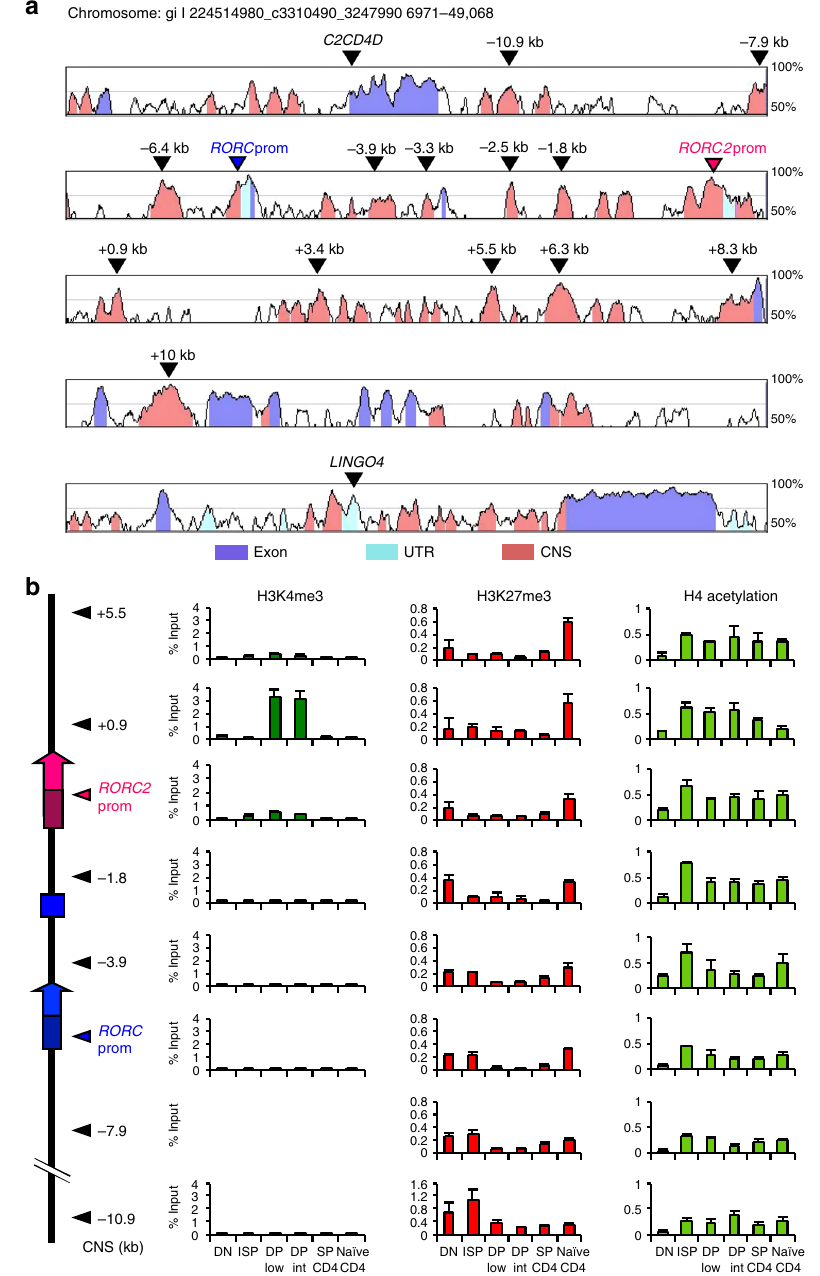
Fig. 2 Global remodeling of the RORC locus during thymocyte differentiation. a Alignment of the human and murine RORC loci, obtained with the VISTA browser. The Y -axis displays the percentage of identity between sequences. Regions with >70% identity are marked in color: Conserved Non-coding Sequences (CNS) in salmon, 5 ′ and 3 ′ untranslated regions (UTR) in light blue and exons in purple. The arrowheads show the localization of the CNS analyzed in the ChIP assays. CNSs are labeled according to their distance from the RORC2 Transcription Start Site. b The diagram on the left shows the organization of the RORC locus. The genomic regions ampli fi ed are marked with arrowheads. Enrichment of H3K4me3 (left panels), H3K27me3 (middle panels), and H4Ac (right panels) was analyzed by ChIP assay in DN, ISP, DP CD3low, DP CD3 intermediate, SP CD4 thymocytes, and naive CD4 + T cells from cord blood. Average and SD of three replicates are represented. Source data are provided as a Source Data fi